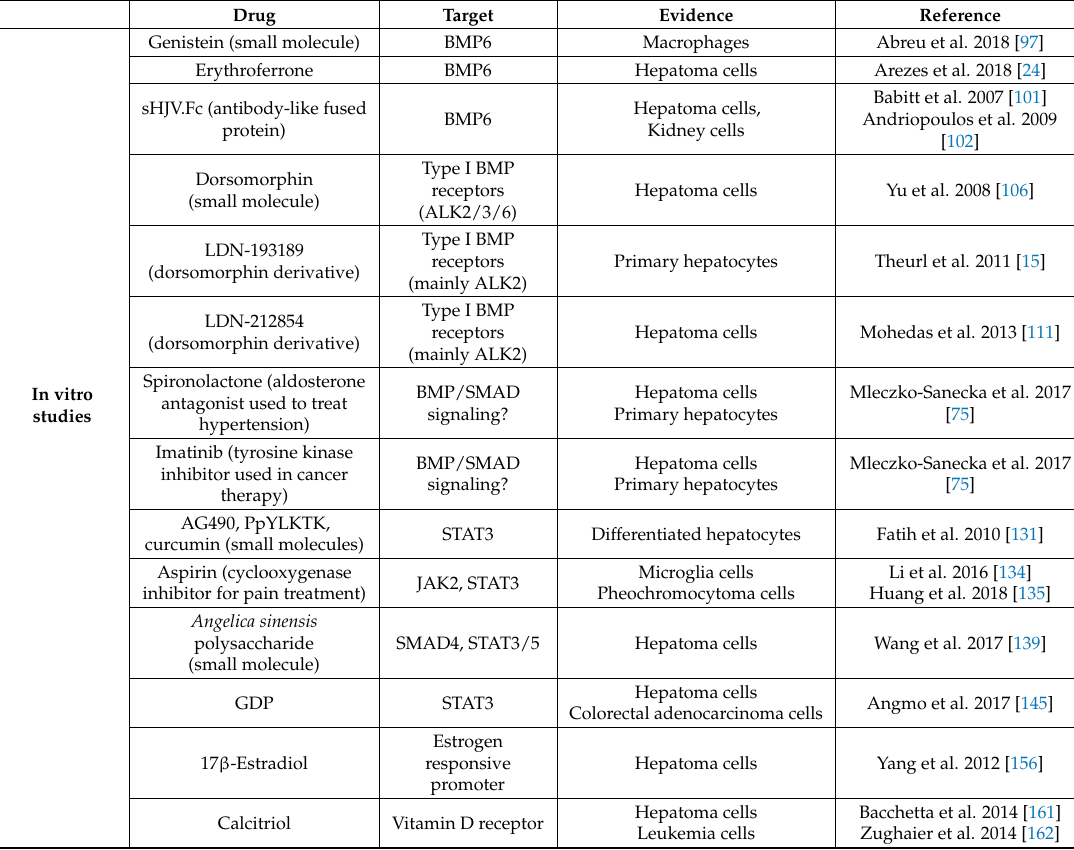
Table 4. Inhibitors of hepcidin expression. ALK, activin receptor-like kinase; IL-6, interleukin 6; EGFR, epidermal growth factor receptor; CKD, chronic kidney disease. Drug Target Evidence